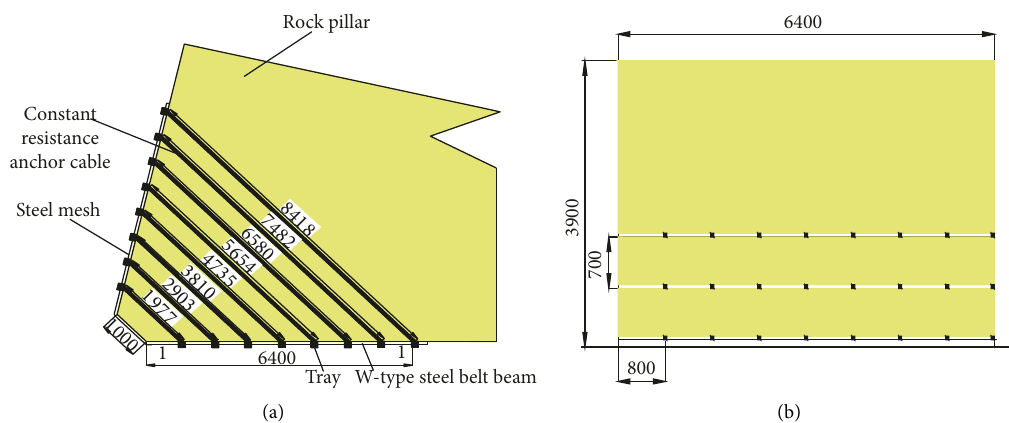
Figure 11: Layout of dual-control constant-resistance coupling control system, (a) Layout plan of dual-control anchor cable, (b) 1–1 section